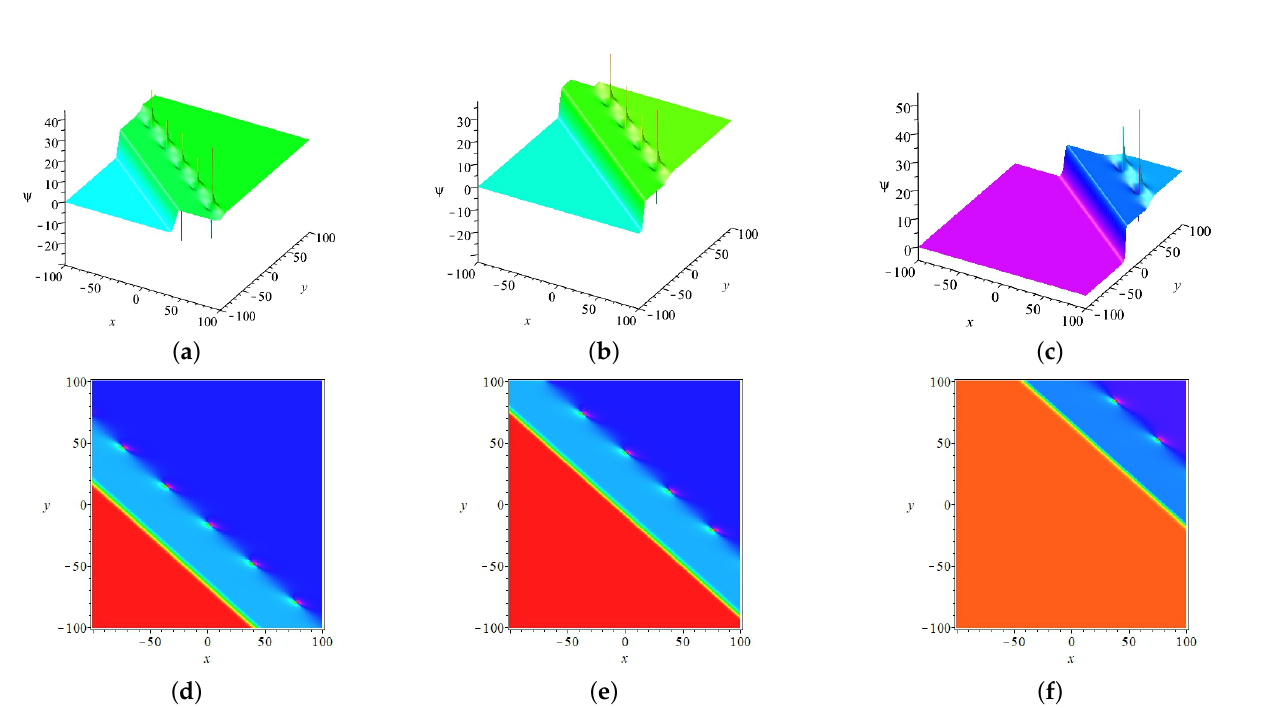
Figure 12. (Color online) The molecular state between quasi-kink soliton and breather with r 2 = r 3 = r 4 = r 6 = r 7 = r 8 = 1, β 1 = β 3 = 2, κ 1 = κ 2 = 0, a 1 = 1, b 1 = 0.1, c 1 = 1.2, d 1 = 0, e 1 = 1.5, f 1 = − 2.5, γ 1 = 10, a 2 = 0.2, b 2 = 0, c 2 = 1.2, d 2 = 1, e 2 = 2